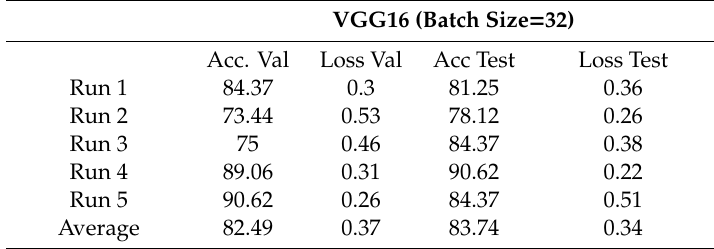
Table A3. VGG16 (epochs = 200, dropout = 0.2, pixel = 256 × 256) runs for di ff erent batch